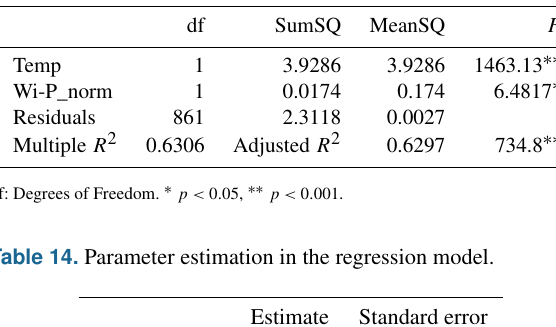
Table 13. Analysis of variance (ANOVA).